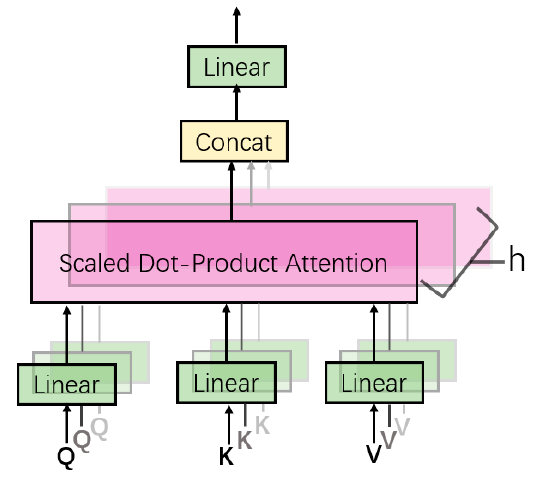
Figure 3. The structure of multi-head attention.